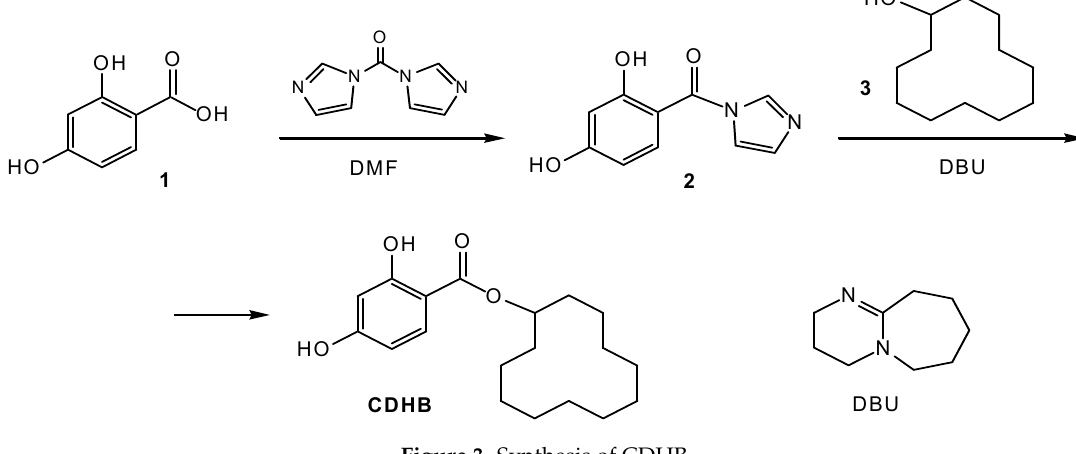
Figure 3. Synthesis of CDHB.